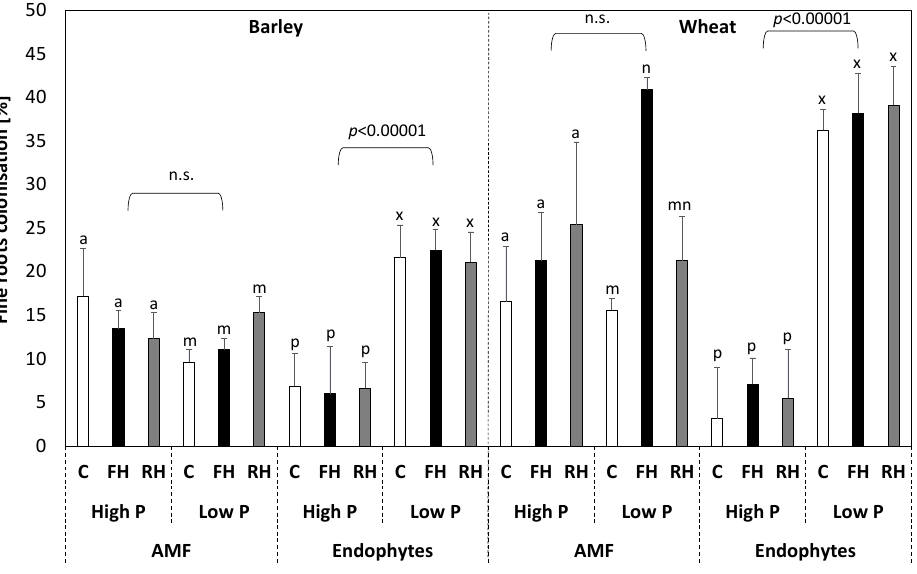
Fig 3. Effect of the experimental treatments on colonisation of fine roots by AMF and endophytic fungi, tested on barley and wheat in the pot experiment. Only treatments that received AMF inoculation were assessed both at high and low soil P-level and after leaf application of protein hydrolysates (FH, chicken feather hydrolysate; RH, reference protein hydrolysate) or mock solution (C, corresponding controls). Different letters indicate statistical differences at the probability level of p <0.05 between hydrolysate treatments (separately within each combination of fungal groups and P-level). The impact of P-level assessed within given fungal group (AMF, endophytes) is indicated above the horizontal